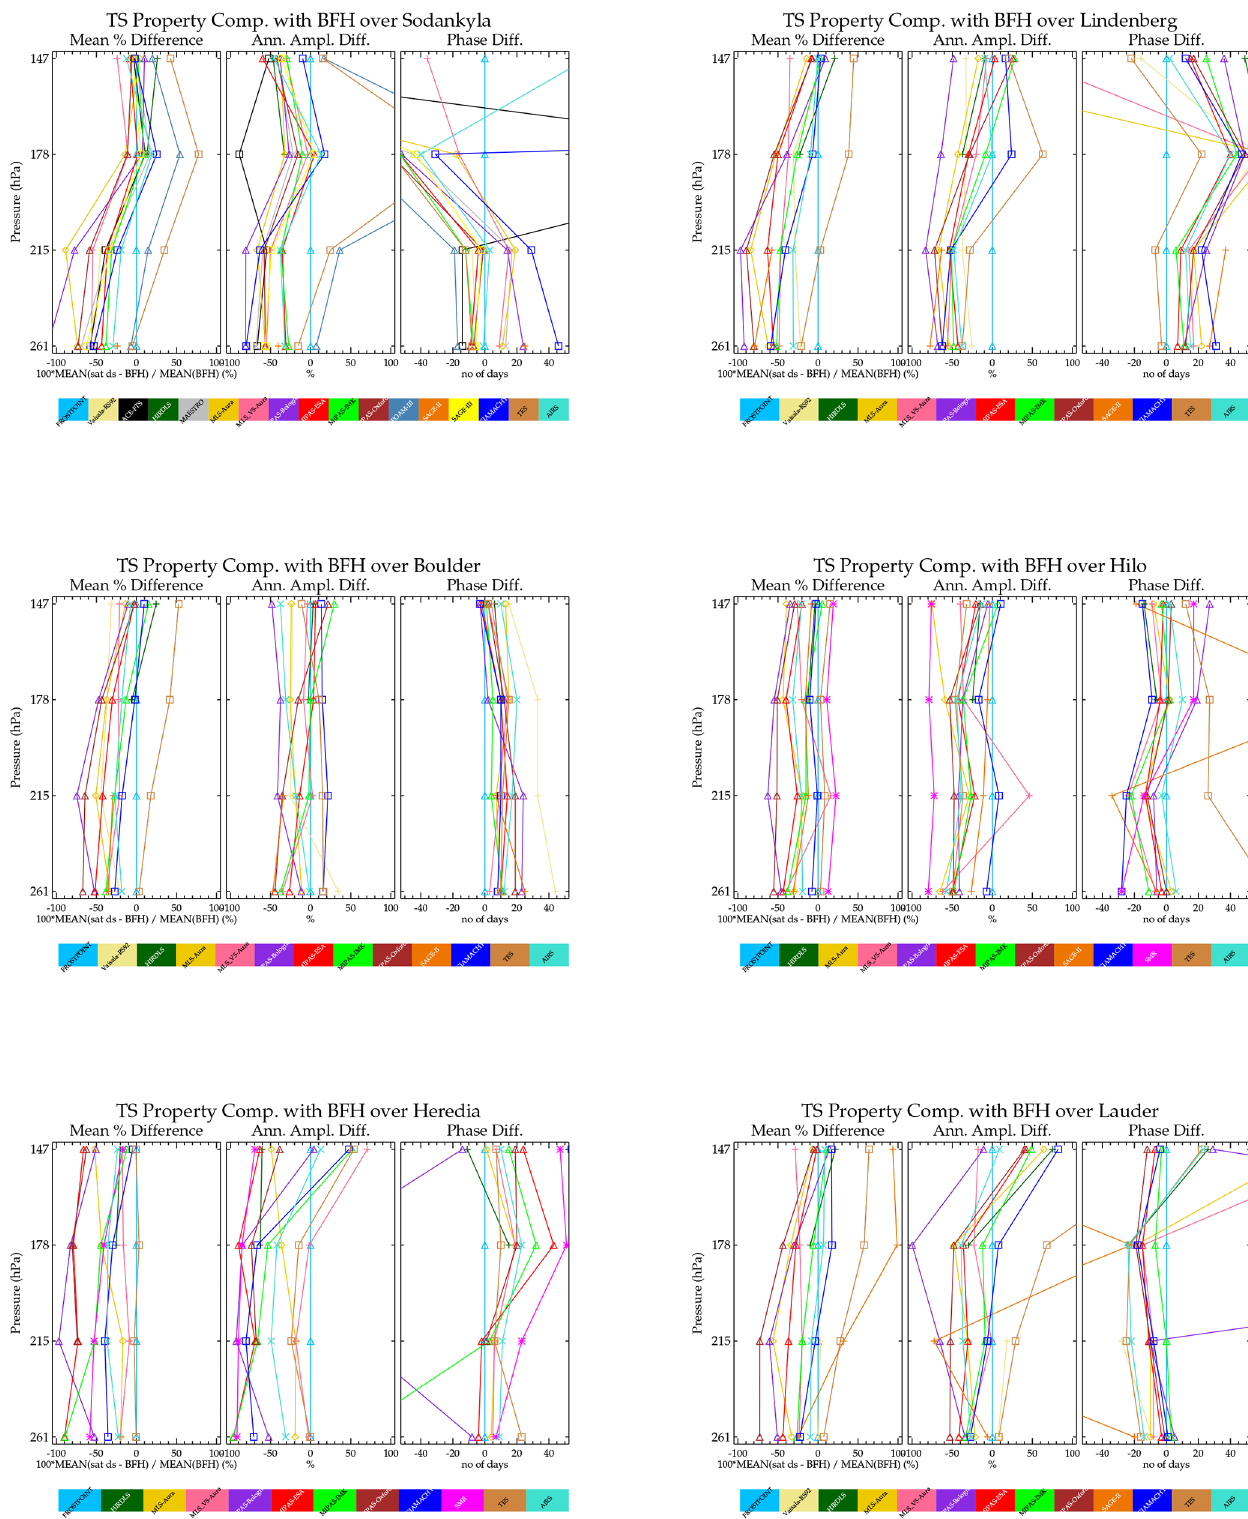
Figure 13. Comparisons of fitted periodic function parameters (mean value, left; amplitude, center; and phase, right) between a data set (colored line) and BFH sonde as a function of altitude